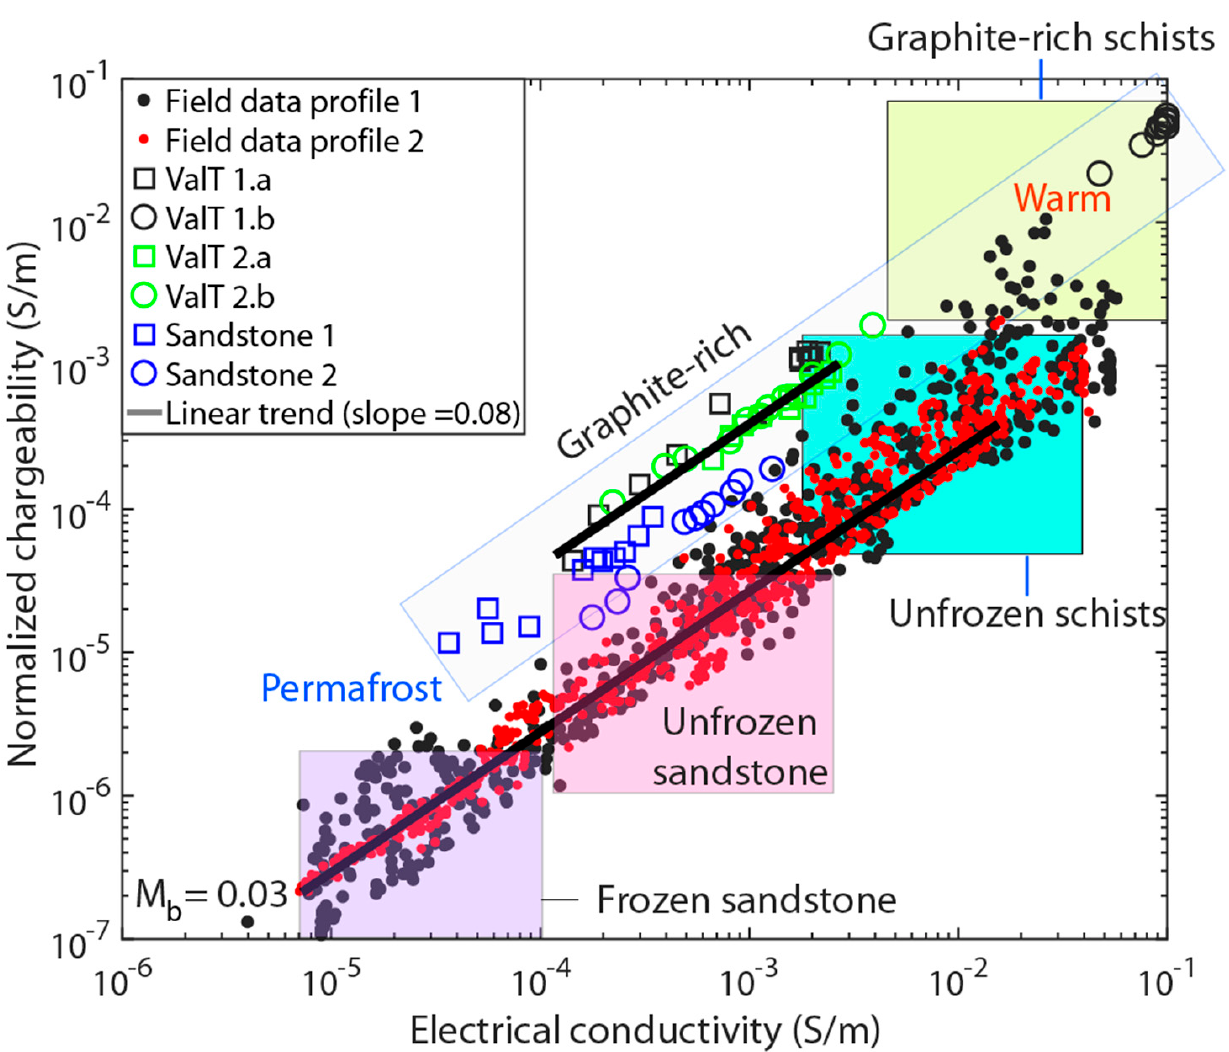
Figure 31. Normalized chargeability versus electrical conductivity at different temperatures for inverted field data (red- and black-filled circles) and laboratory experiments (open squares and circles). The data above the lower plain line indicate that the sample contains semiconductor or metallic particles. The normalized chargeability is calculated from the equation: M n = M σ ∞ , where σ ∞ and M (= M 1) come from the fitting with a double Cole–Cole model, which corresponds to Equation (42). The grey area corresponds to the graphite-rich zone. The high and low values of the normalized chargeability and conductivity are also controlled by the lithology. Modified from [43].